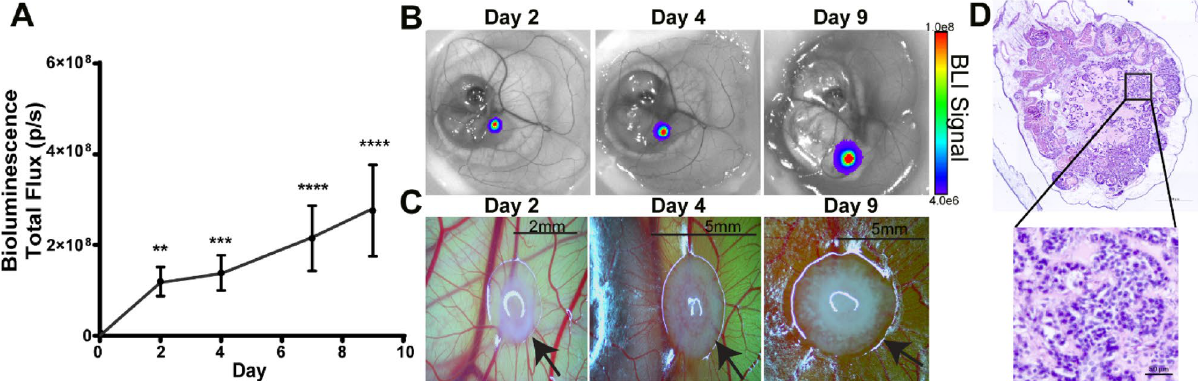
Figure 3. Engineered MCF7luc spheroids growth profile on the chick embryo chorioallantoic membrane (CAM). ( A ) Tumor spheroid growth curve of engineered MCF7luc spheroid (0.5 × 10 5 cells/ spheroid) on the chick CAM post engrafting (n = 14). Error bars represent SEM, asterisk denotes significance, Kruskal–Wallis test. ( B ) Representative image of MCF7luc spheroid on CAM measured via IVIS. ( C )